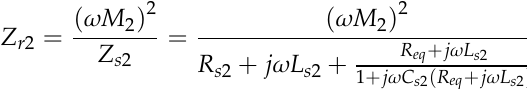
Figure 15. Equivalent S-LCL compensation topology.